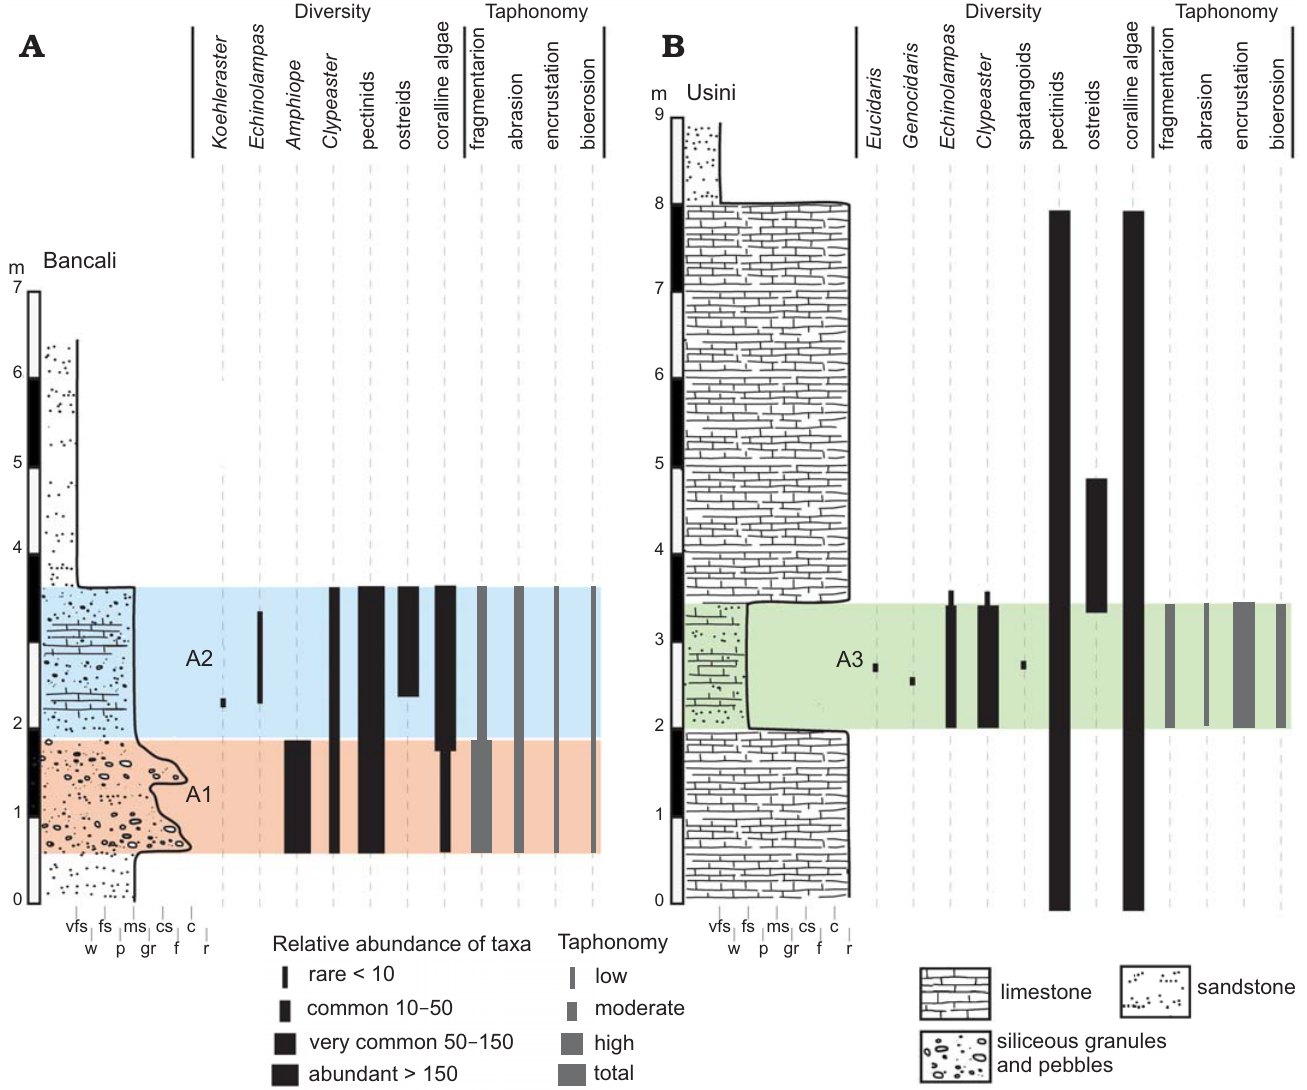
Fig. 3. Stratigraphic sections of Bancali ( A ) and Usini ( B ) with distribution and relative abundance of recognized echinoids and associated macrofauna and flora. Abbreviations: A1, Bancali Assemblage 1; A2, Bancali Assemblage 2; A3, Usini Assemblage; c, conglomerate; cs, coarse sandstone; f, floatstone; fs, fine sandstone; gr, grainstone; ms, medium sandstone; p, packstone; r, rudstone; vfs, very fine sandstone; w,